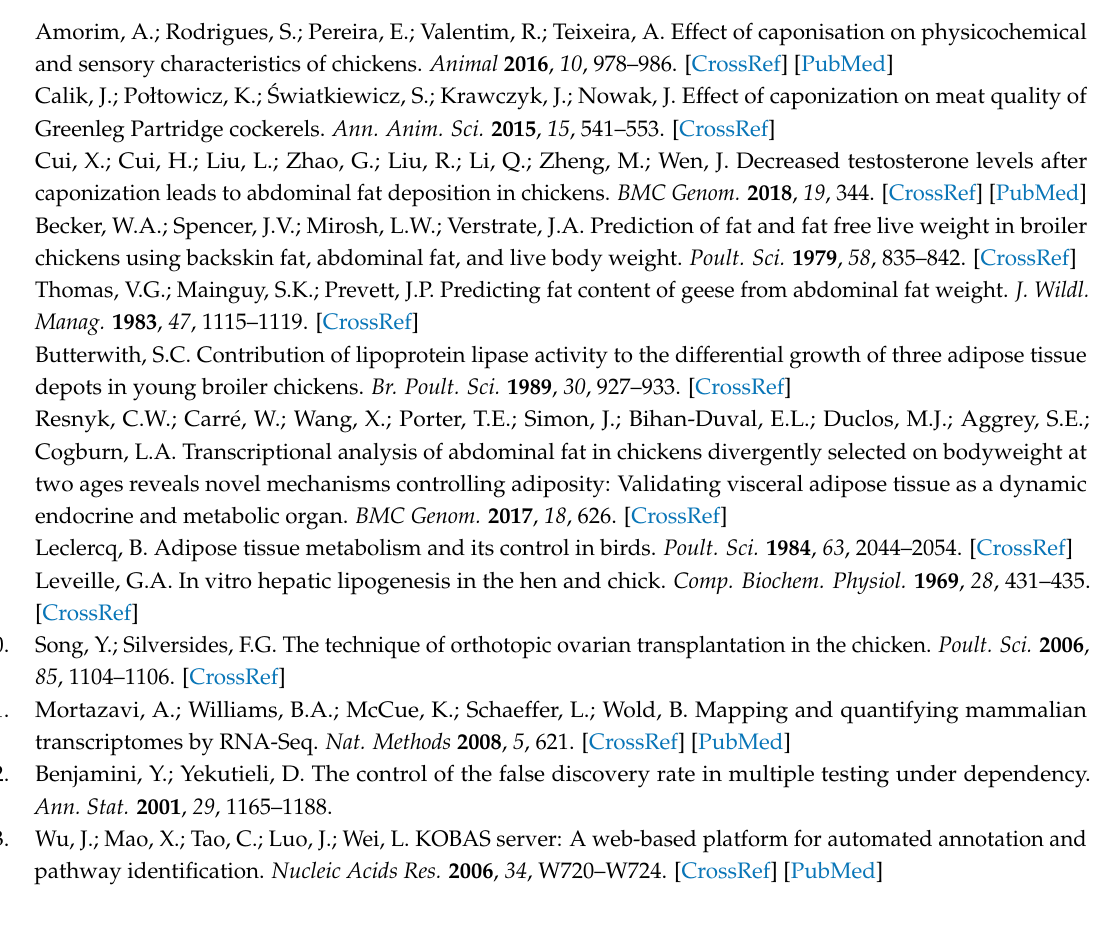
Table S1: The specific qRT-PCR primers in this study (XLSX). Table S2: The screened 1461 DEGs in the study (XLSX). Table S3: The enriched the GO terms based on 1461 DEGs (XLSX). Table S4: The 108 DEG related to lipid metabolism